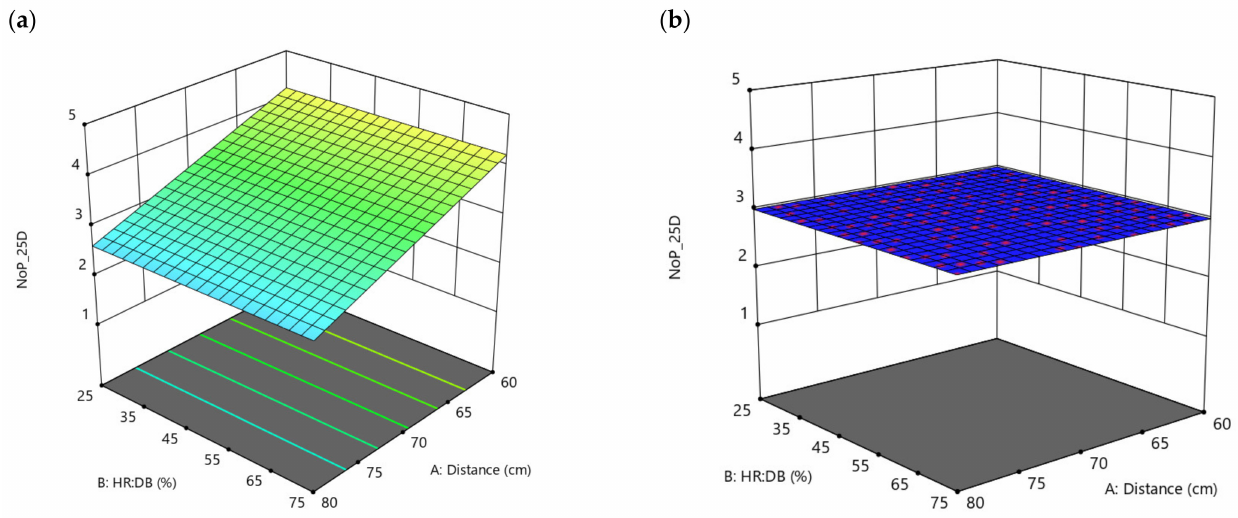
Figure 8. Contour plots of the models related to the property NoP: ( a ) NoP_25D with White LEDs;